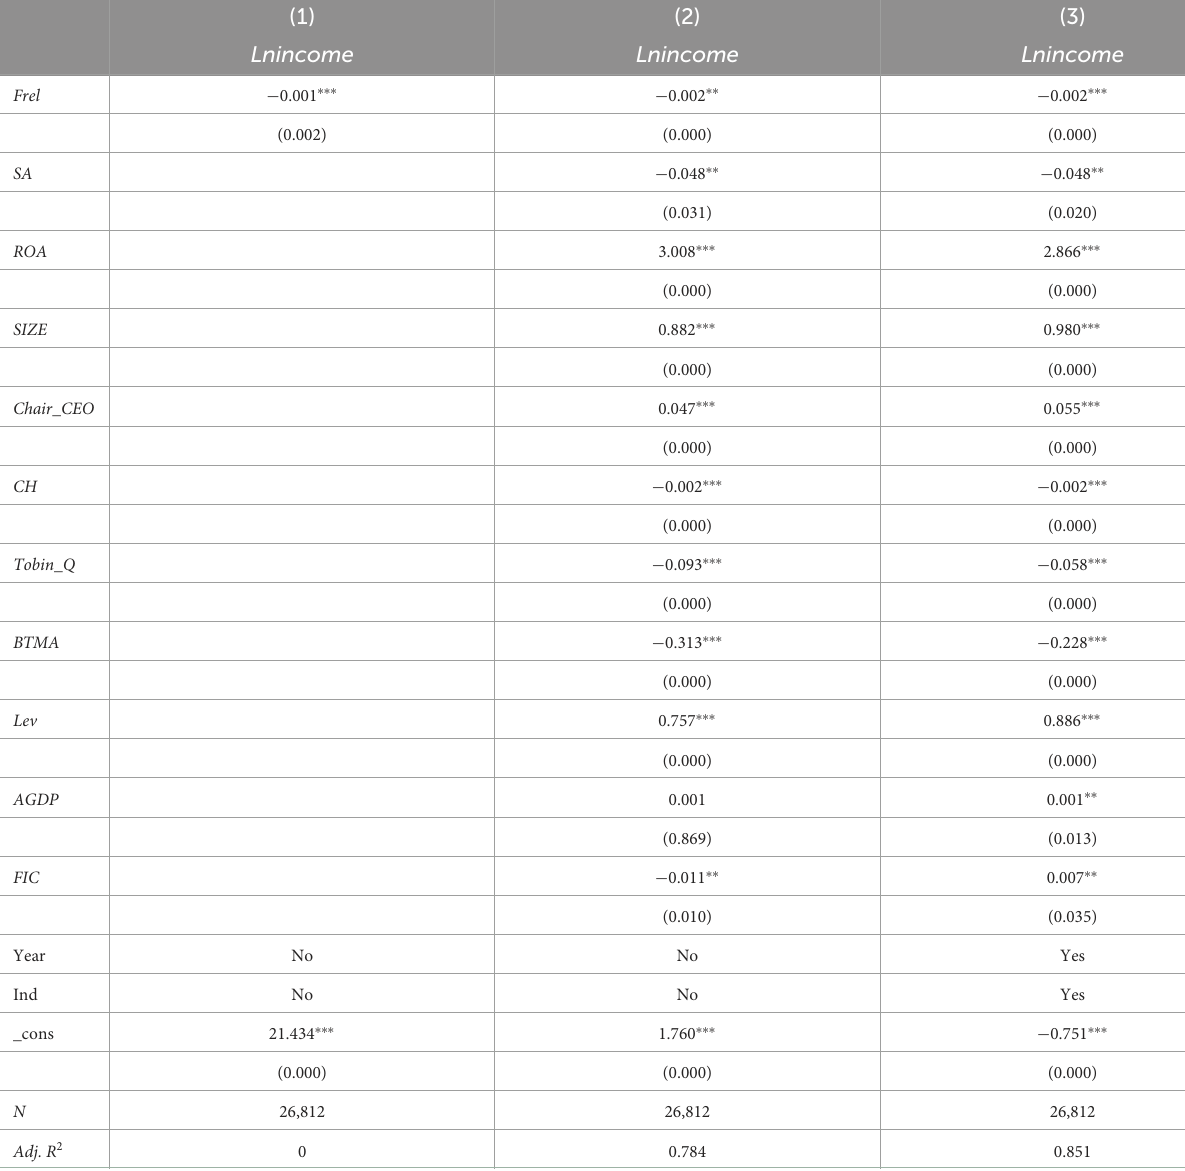
TABLE 5 Regression results when using the extreme climate